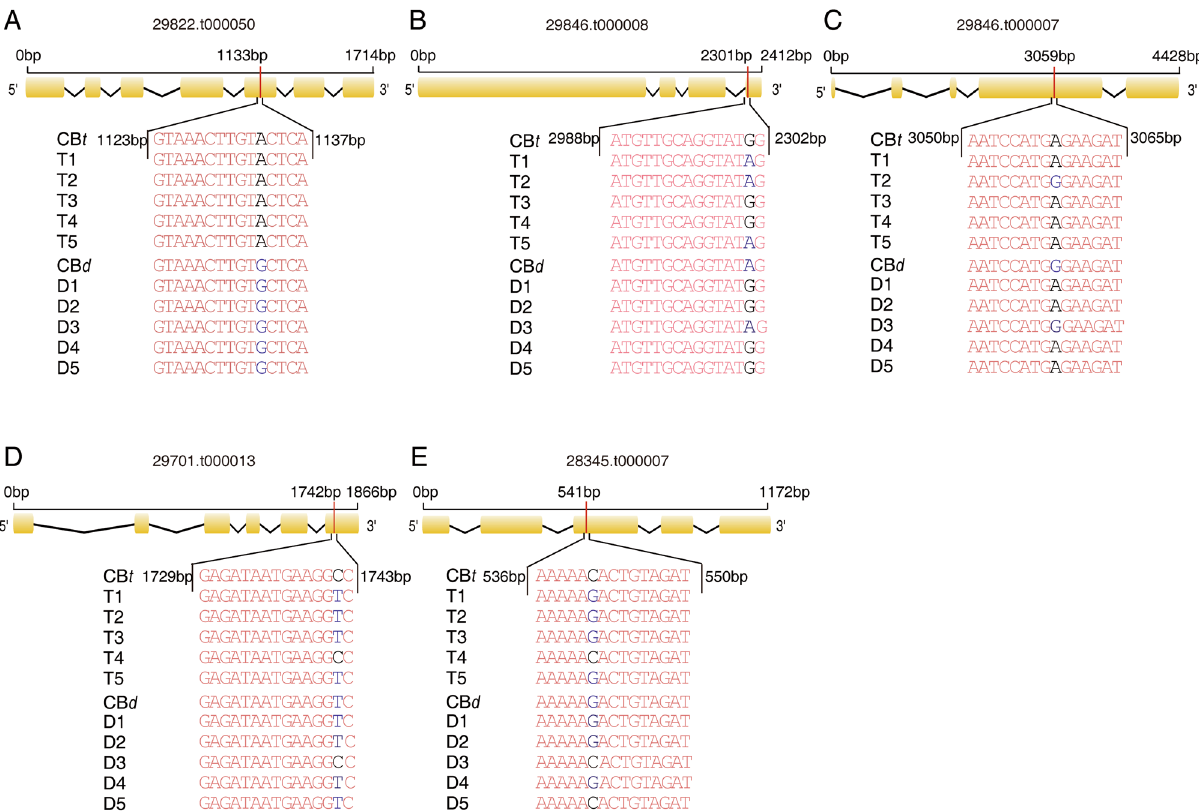
Figure 4. ΔSNP index ≥ 0.6 non-synonymous SNPs identification for five candidate genes obtained from 10 castor varieties. ( A )–( E ) The exon (box) and intron (line) structure of 29,822.t000050, 29,846.t000008, 29,846.t000007, 29,701.t000013 and 29,345.t000007 and the genotypes of non-synonymous SNPs with ΔSNP index ≥ 0.6 in tall (T) and dwarf (D) accessions determined using PCR and sequencing. Collection location and plant height of the 10 varieties are shown in Table